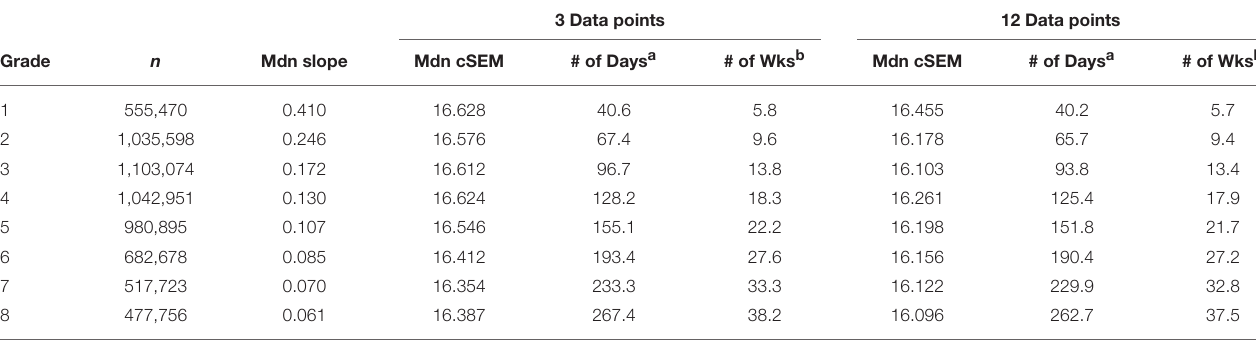
TABLE 1 | Summary of normative refence point